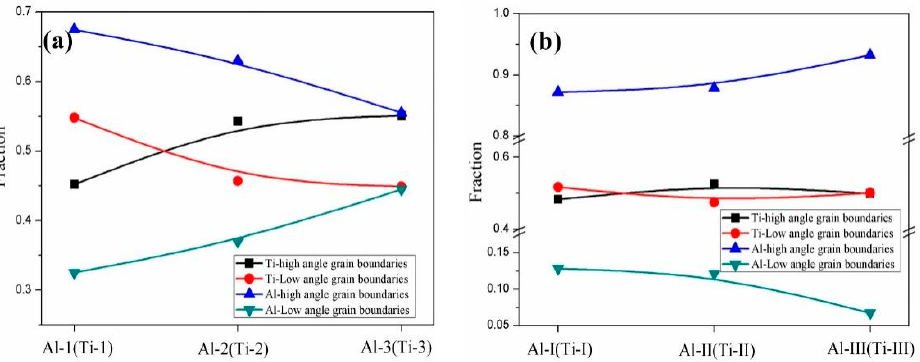
Figure 19. Misorientation distribution in different regions near the interface of specimen B3. ( a ) Ti-I; ( b ) Ti-II; ( c ) Ti-III; ( d ) Al-I; ( e ) Al-II; ( f ) Al-III.